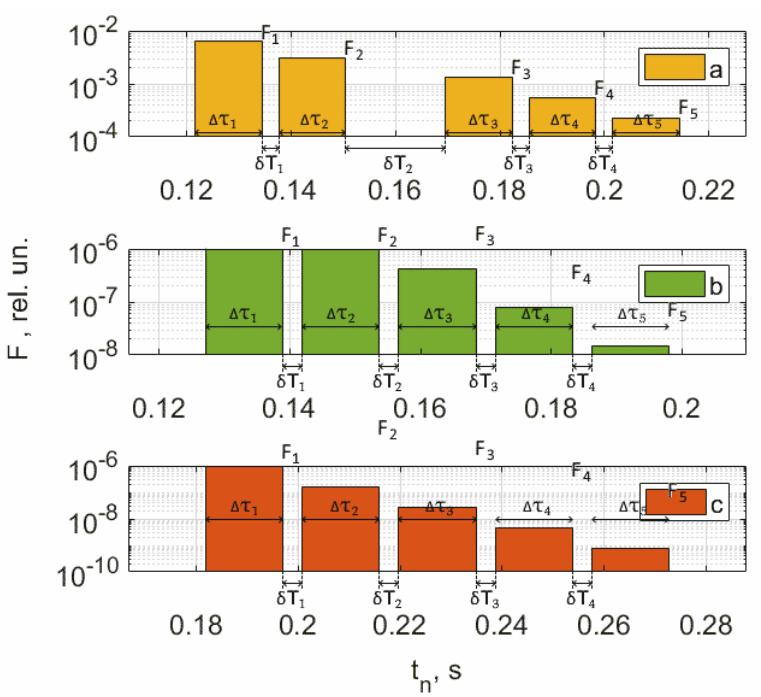
Figure 10. Results of processing the rise front of the pulse wave. The first patient ( a ) is a 25-year-old man, ( b ) is a 28-year-old man, ( c ) is a 30-year-old man.